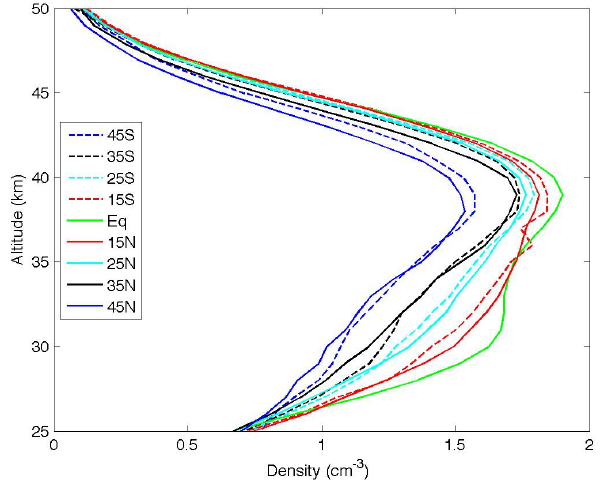
Fig. 26. The NO 3 constant term c(z) as a function of altitude for several latitude belts. The profile values are scaled by 10 7